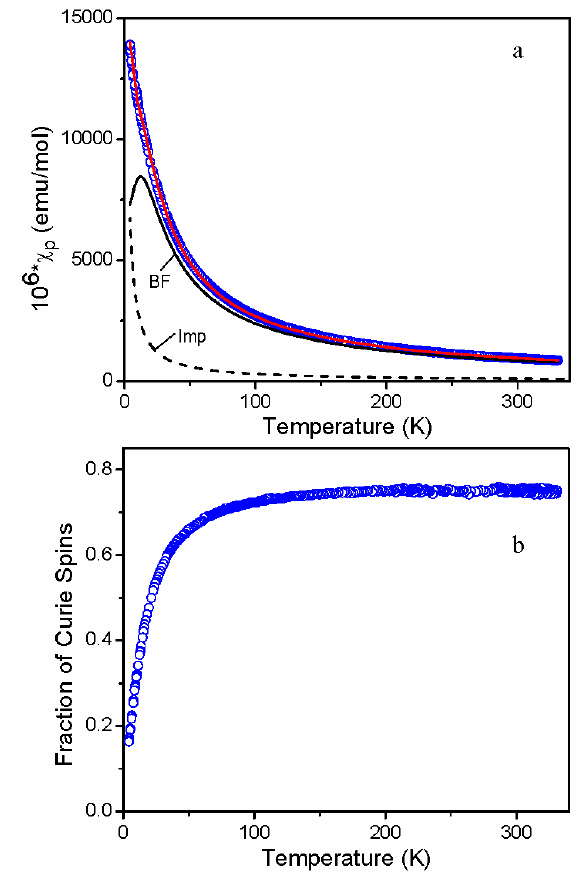
Figure 7. ( a ) Magnetic susceptibility of 11 as a function of temperature. Red line represents the fitting for magnetic susceptibility of 11 to the Bonner-Fisher model for the S = 1/2 antiferromagnetic Heisenberg chain of isotropically interacting spins which includes the contribution of paramagnetic impurities (dashed line) and Bonner-Fisher (BF) component (black solid line) corresponding to J = −6.3 cm −1 ; ( b ) Fraction of Curie spins per molecule as a function of